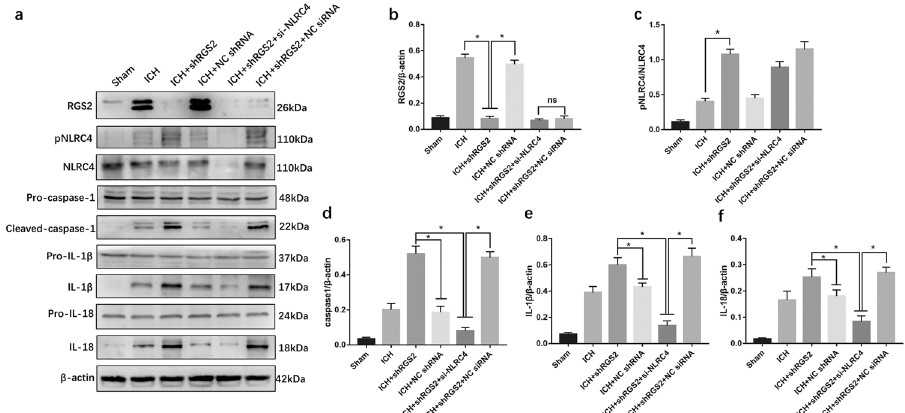
Fig. 5 RGS2 affected NLRC4 in fl ammasome activation following ICH. a – f Western blot assay was used to detect the expression of RGS2, pNLRC4, NLRC4, Pro-caspase-1, caspase-1, Pro-IL-1 β , IL-1 β , Pro-IL-18, and IL-18, in perihematomal area in ICH, Sham, ICH + shRGS2, ICH + negative control shRNA (ICH + NC shRNA), ICH + shRGS2 + si-NLRC4 and ICH + shRGS2 + NC siRNA at 72 h after ICH (6 rats for each